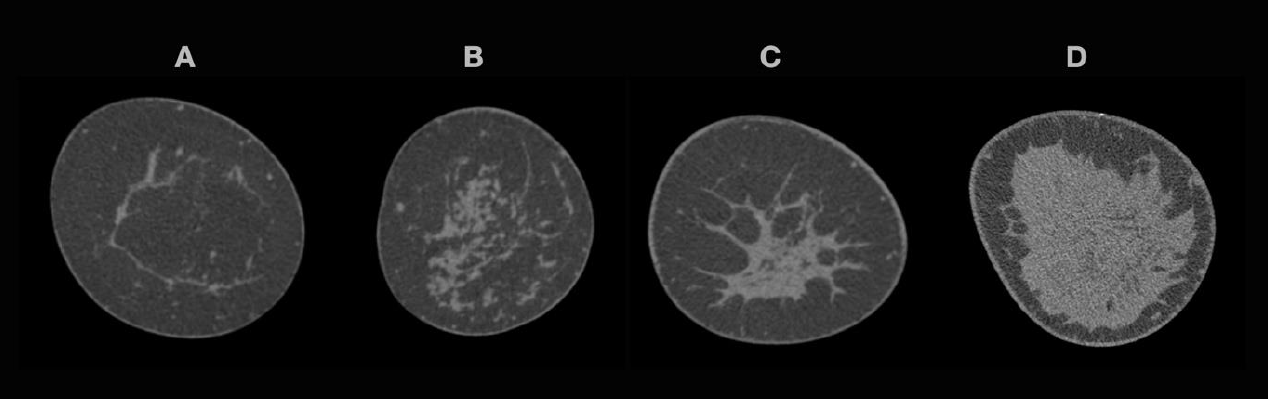
Figure 1. Spiral breast-CT density classification with one example for each category. ( A ). Partial or complete involution with every lesion visible; ( B ). Scattered glandular tissue with lesions larger than 10 mm conclusively visible; ( C ). Heterogenous dense glandular tissue with lesions of 10 mm potentially not visible; ( D ). Very dense tissue with restricted visibility of lesions. Raw data images with 0.3 mm slice thickness, coronal plane.